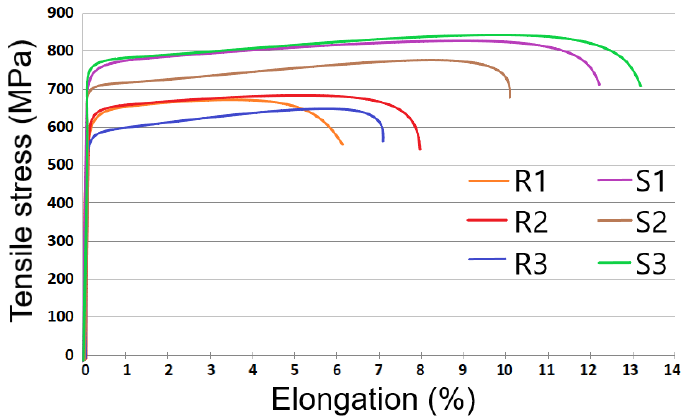
Figure 10. Representative tensile stress vs. elongation plots obtained through mechanical tests on SLM-manufactured samples (relatively and stable processability). Table 4. Tensile test results of SLM-processed 316L samples.